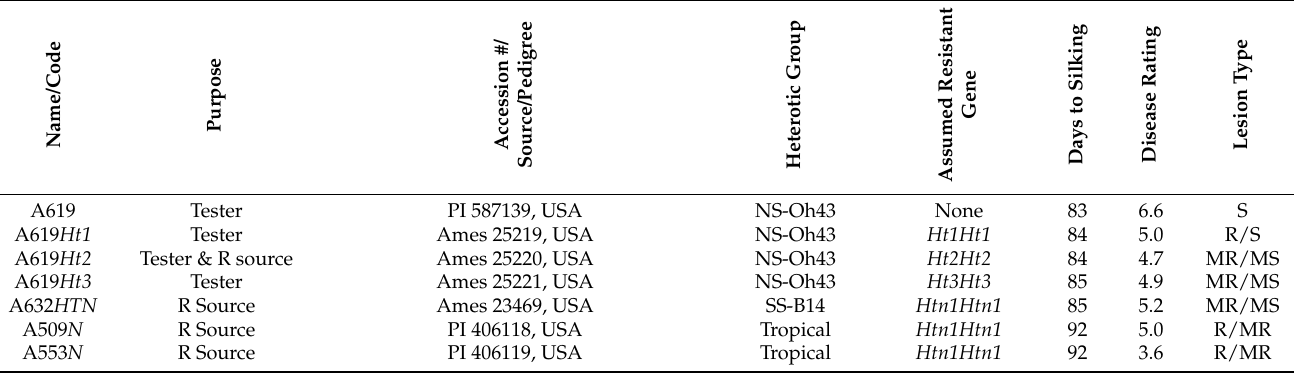
Table 1. Accession # /Sources/Pedigrees, heterotic groups, assumed resistant genes, and days to silking of 35 inbreds and their disease ratings, and lesion types under an artificial epidemic of northern corn leaf